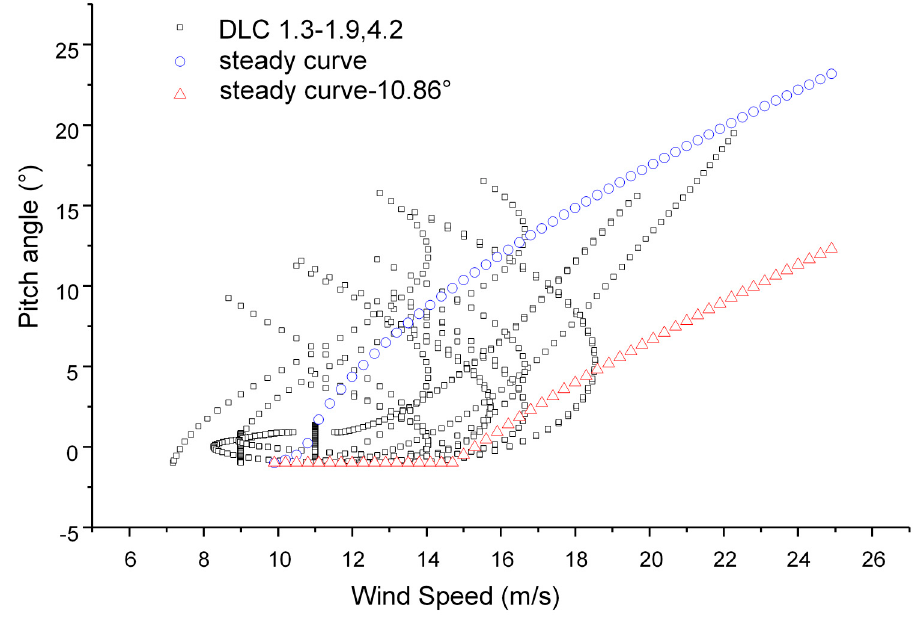
Figure 2. Pitch angle versus wind speed at hub center in some load cases.